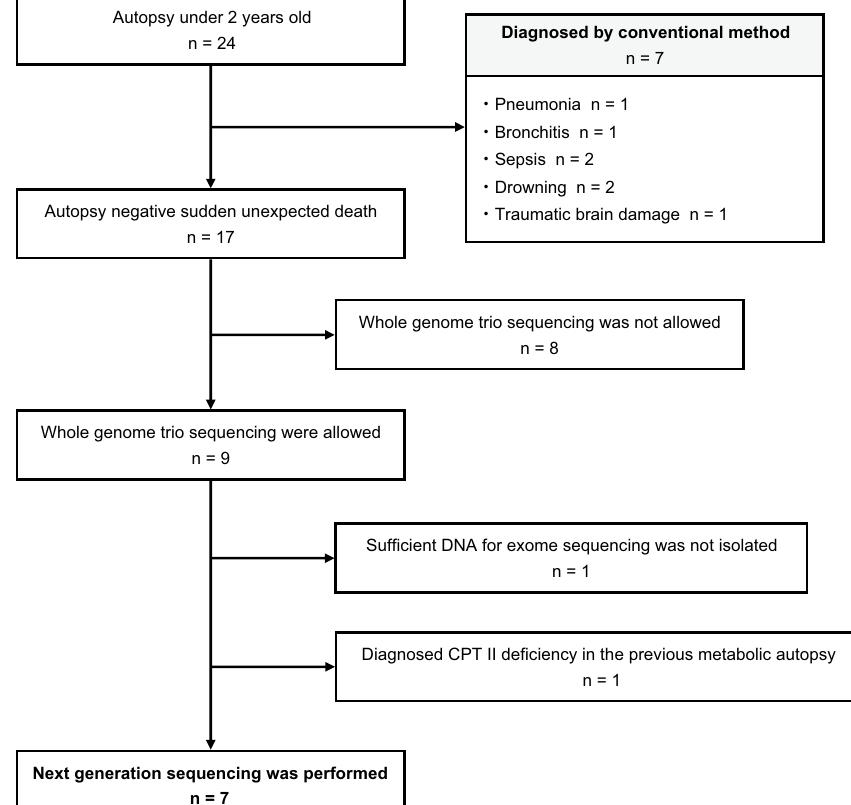
Figure 1. Flowchart of the selection process showing the number of participants in this study. Autopsy negative means that the case was not diagnosed even after macroscopic and microscopic examinations and a toxicology examination. Abbreviation: CPT II: carnitine palmitoyltransferase